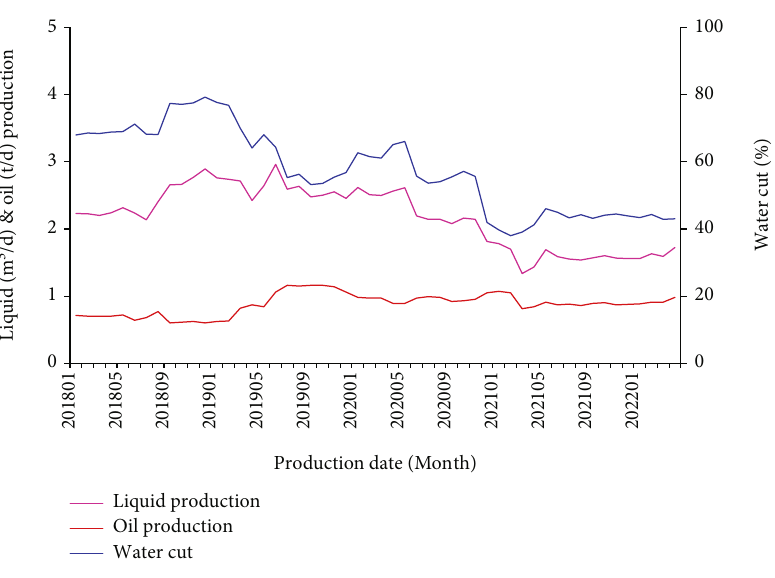
Figure 7: Production curve of test well group.